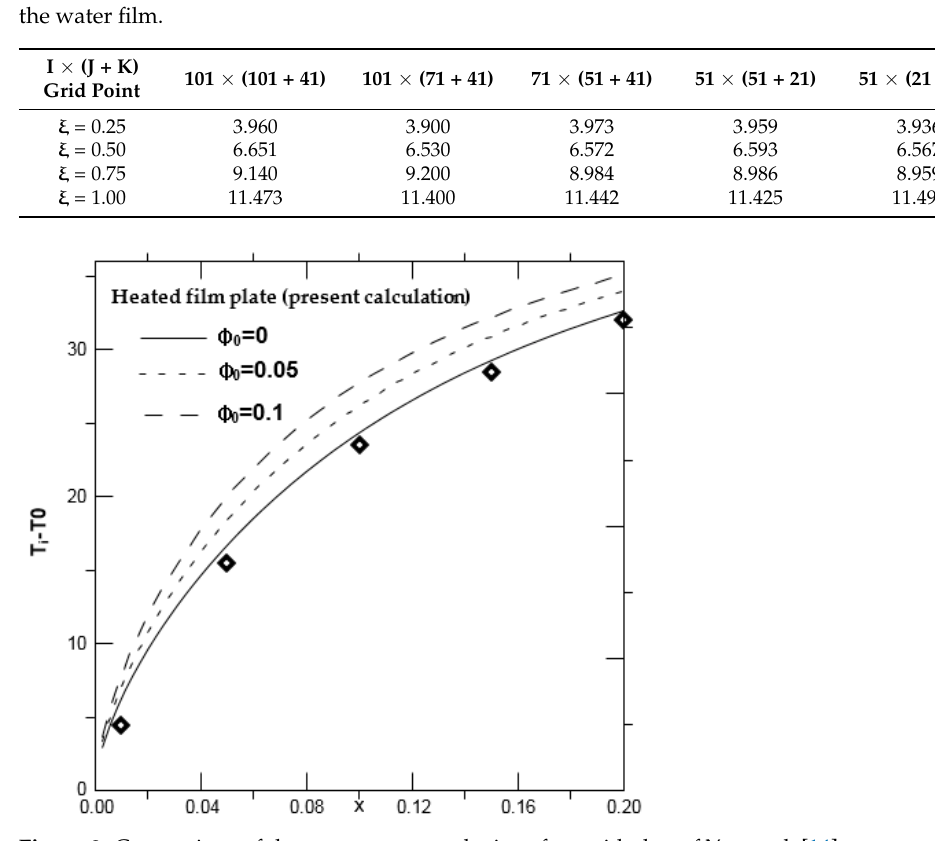
• m ( ξ ) (kg.s − 1 .m − 2 ) of